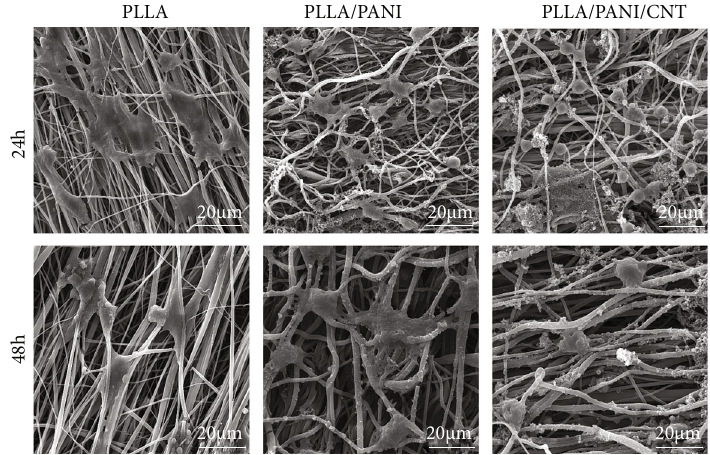
Figure 5: Scanning electron micrographs of L929 fi broblast cells cultured on PLLA, PLLA/PANI, and PLLA/PANI/CNT nano fi bers at 24 and 48